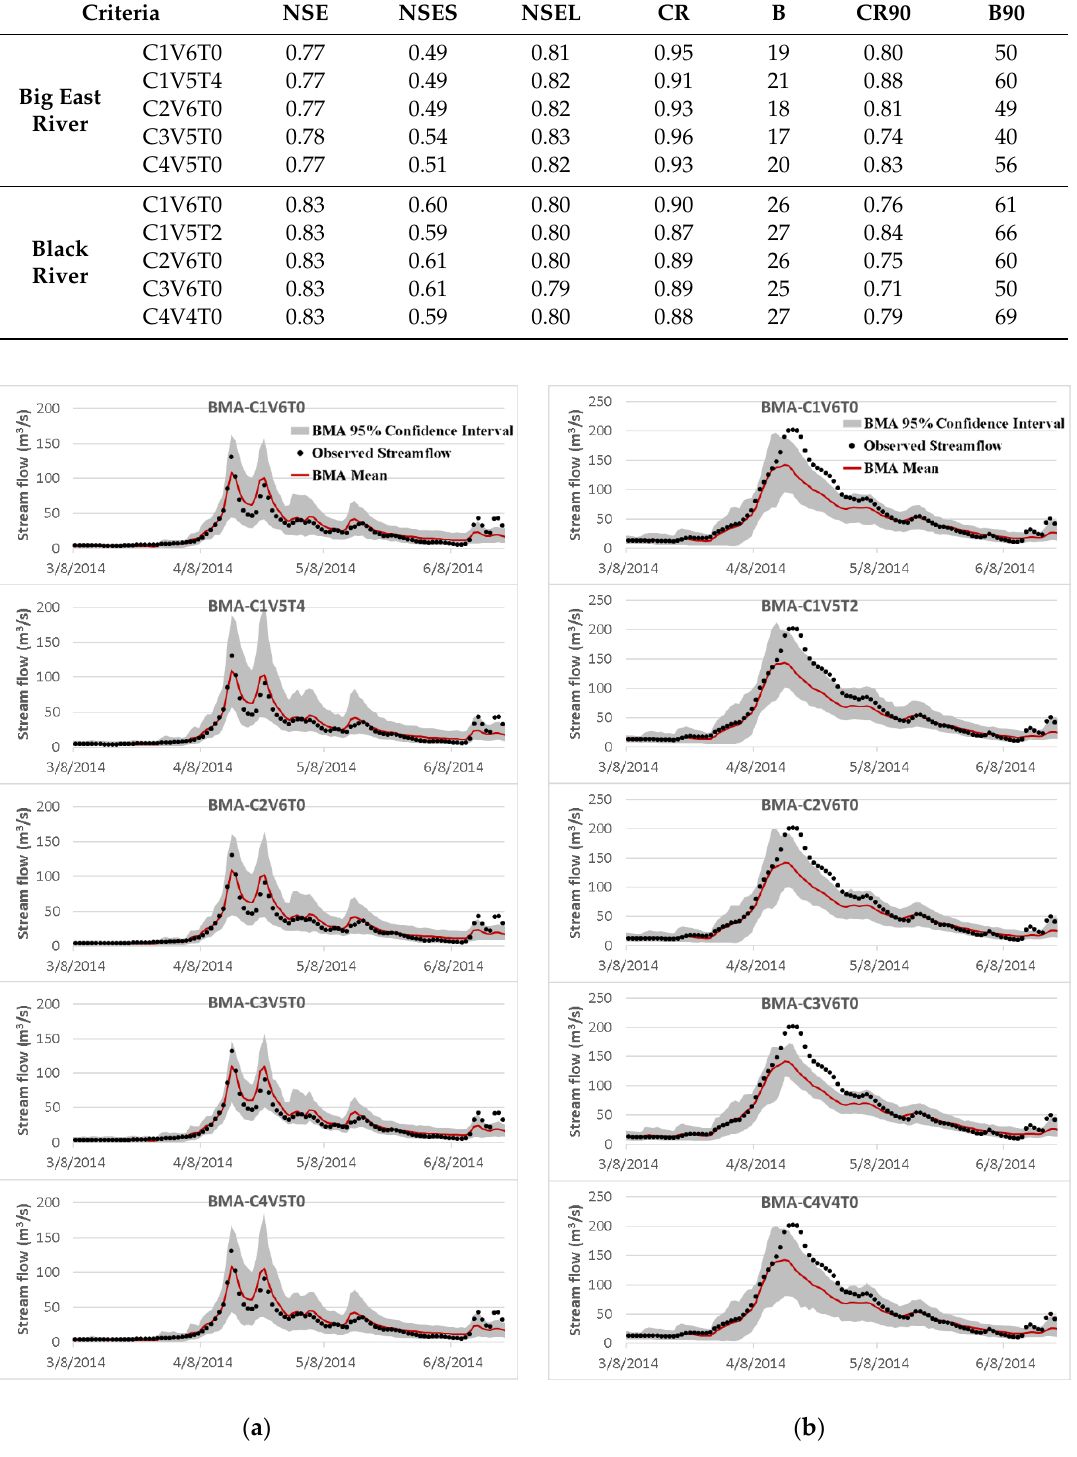
Figure 14. Time-series of the mean and 95% predictive bounds of daily streamflow derived from the best-selected BMA models for a representative portion of the validation period for both the ( a ) Big East River and ( b ) Black River watersheds.